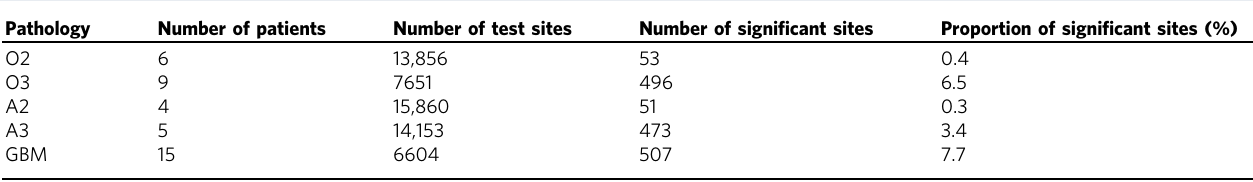
Table 1 Summary of A-to-I editing sites according to pathologies in glioma Test sites are the A-to-I editing sites found in all patients for a given